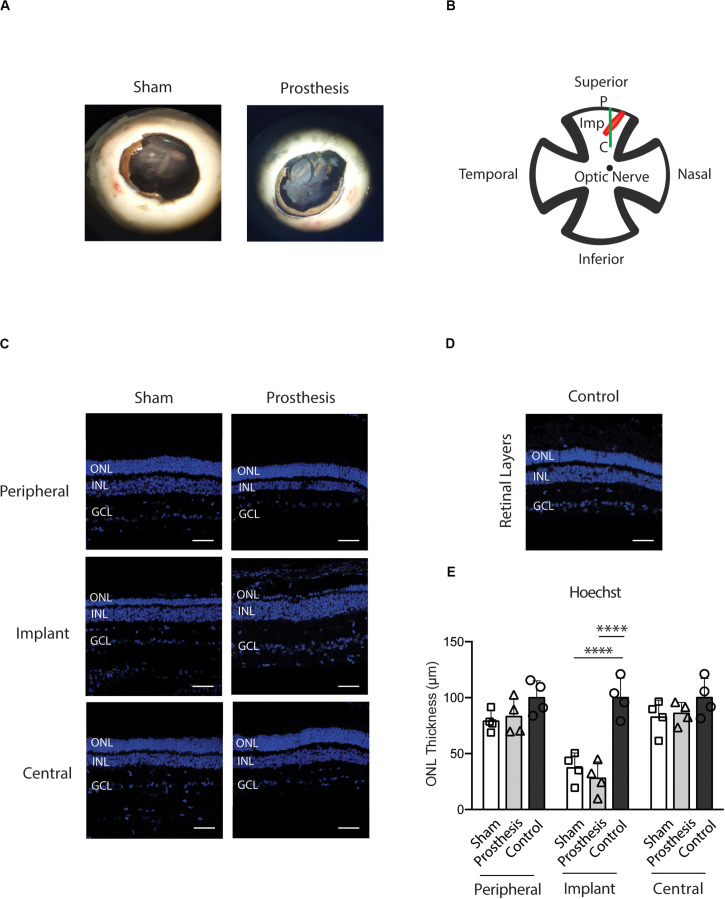
Morphology of the ONL after implantation of PET-based devices in the pig. (A) Representative eyecups of sham- and prosthesis-implanted pigs. All the examined eyes had no overt signs of inflammatory reaction or displacement of the implants from the insertion place. (B) Cartoon depicting the retinal areas (“peripheral,” “implant,” and “central”) that were sampled in sham- and prosthesis-implanted eyes. (C,D) Representative retina sections stained with bisbenzimide to show the thickness of nuclear layers in “peripheral,” “implant,” and “central” positions in sham- and prosthesis-implanted pigs (C) as well as in the non-implanted control group (D). ONL, outer nuclear layer; INL, inner nuclear layer; GCL, ganglion cell layer; P, Peripheral; Imp, implant; C, central. Scale bars, 50 μm. (E) Bar plots (means ± SD with superimposed experimental points) showing the retinal ONL thickness measured in sham-implanted (white), prosthesis-implanted (light gray) and non-implanted control (dark gray) groups measured in the peripheral, implant and central retinal regions. In the implant area, a significant reduction in the ONL thickness of the sham (p < 0.0001) and prosthesis (p < 0.0001) group with respect to non-implanted controls was observed. No significant changes in retinal thickness in the other retinal regions were found. ****p < 0.0001, two-way ANOVA/Tukey’s tests (n = 4 for each experimental group).